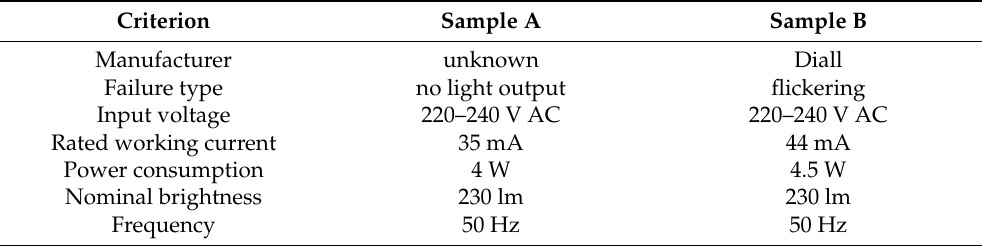
Table 1. Product information in the two LED spotlights